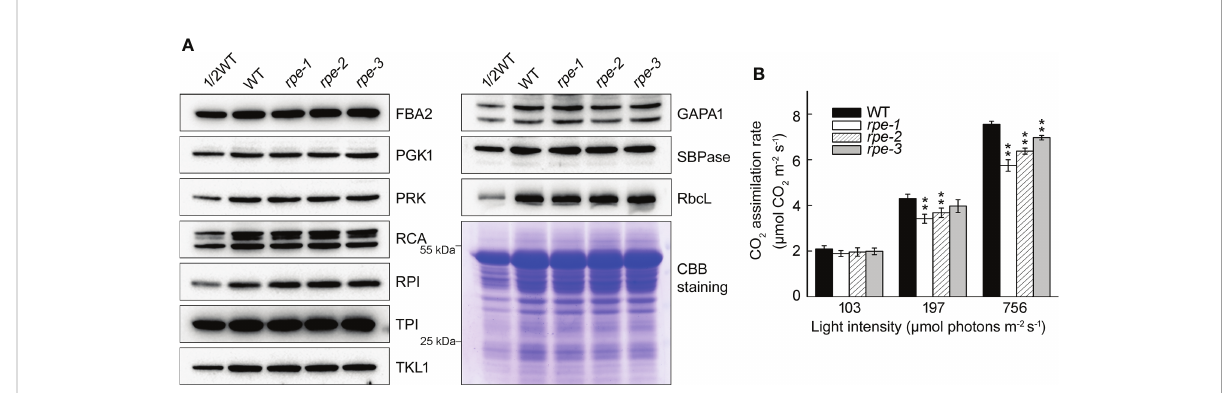
FIGURE 4 Characterization of Calvin-Benson cycle from WT and the rpe mutants. (A) Immunoblot analysis of Calvin-Benson cycle enzymes in WT and the rpe mutants. Chloroplast stroma was isolated and immunoblot analyses were performed using the indicated antibodies. Equal amounts of chloroplast stromal proteins were loaded. The gels were stained with CBB for visualization of the proteins. (B) CO 2 assimilation rate of WT and the rpe mutants under different light intensities. Values are means ± SD (n=3). Signi fi cant differences were performed using the Student ’ s t-test (**P <